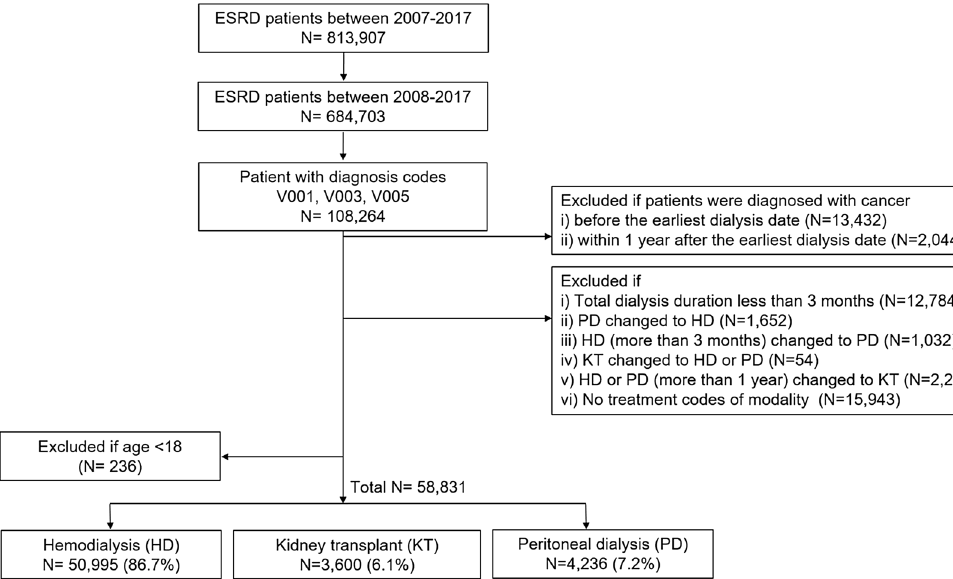
Figure 1. Flowchart of the study population. ESKD, End-stage kidney disease; HD, hemodialysis; PD, peritoneal dialysis; and KT, kidney